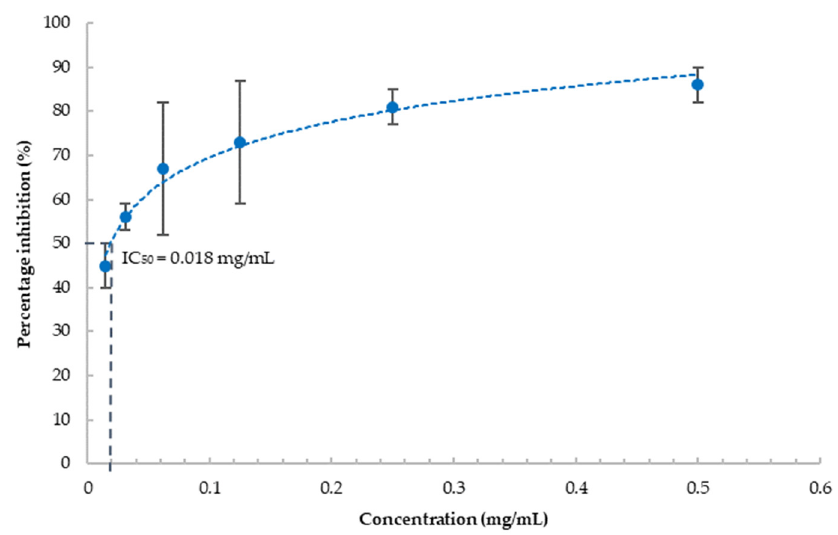
Figure 3. Percentage inhibition of COX-2 by blueberry extract at various concentrations. Values are presented as the mean ± SD of n = 3.